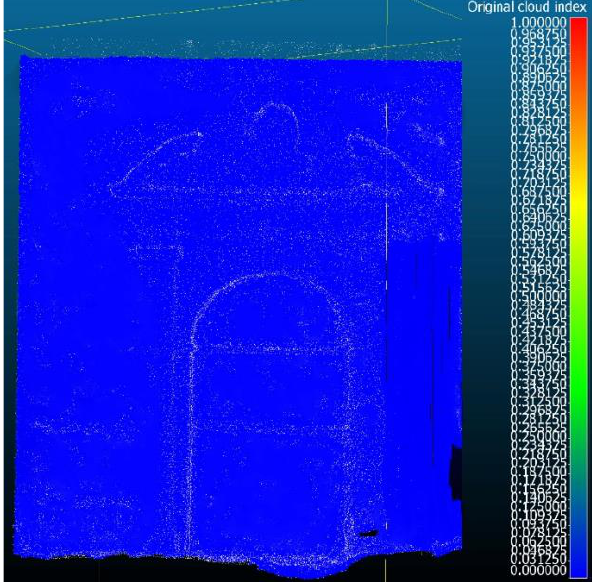
Figure 13: Merge cloud of Super-Image data set dense cloud and ground truth dense cloud. The red colour indicates a major RMS value than blue